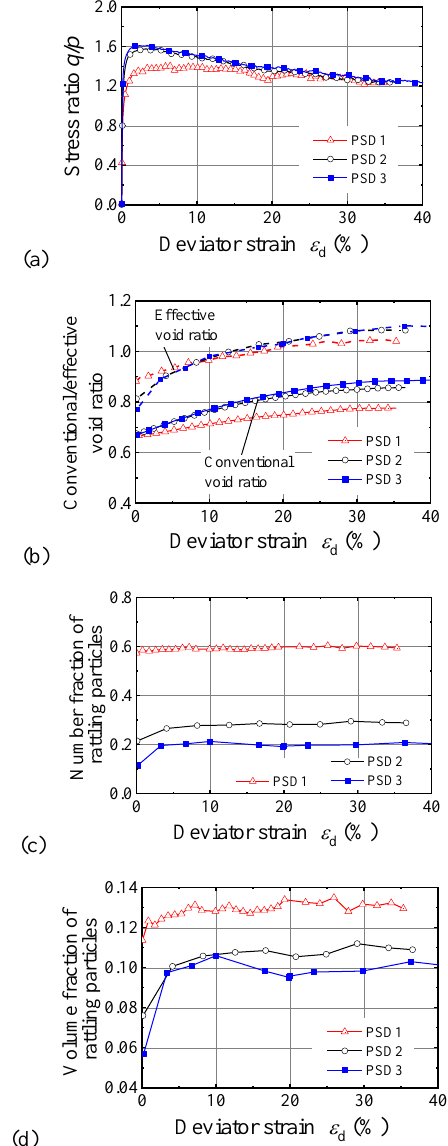
Fig. 4. Effects of particle size distribution on mechanical responses of clean sand ( e 0 = 0.67): (a) stress ratio, (b) conventional and effective void ratios, (c) number fraction of rattling particles, and (d) volume fraction of rattling